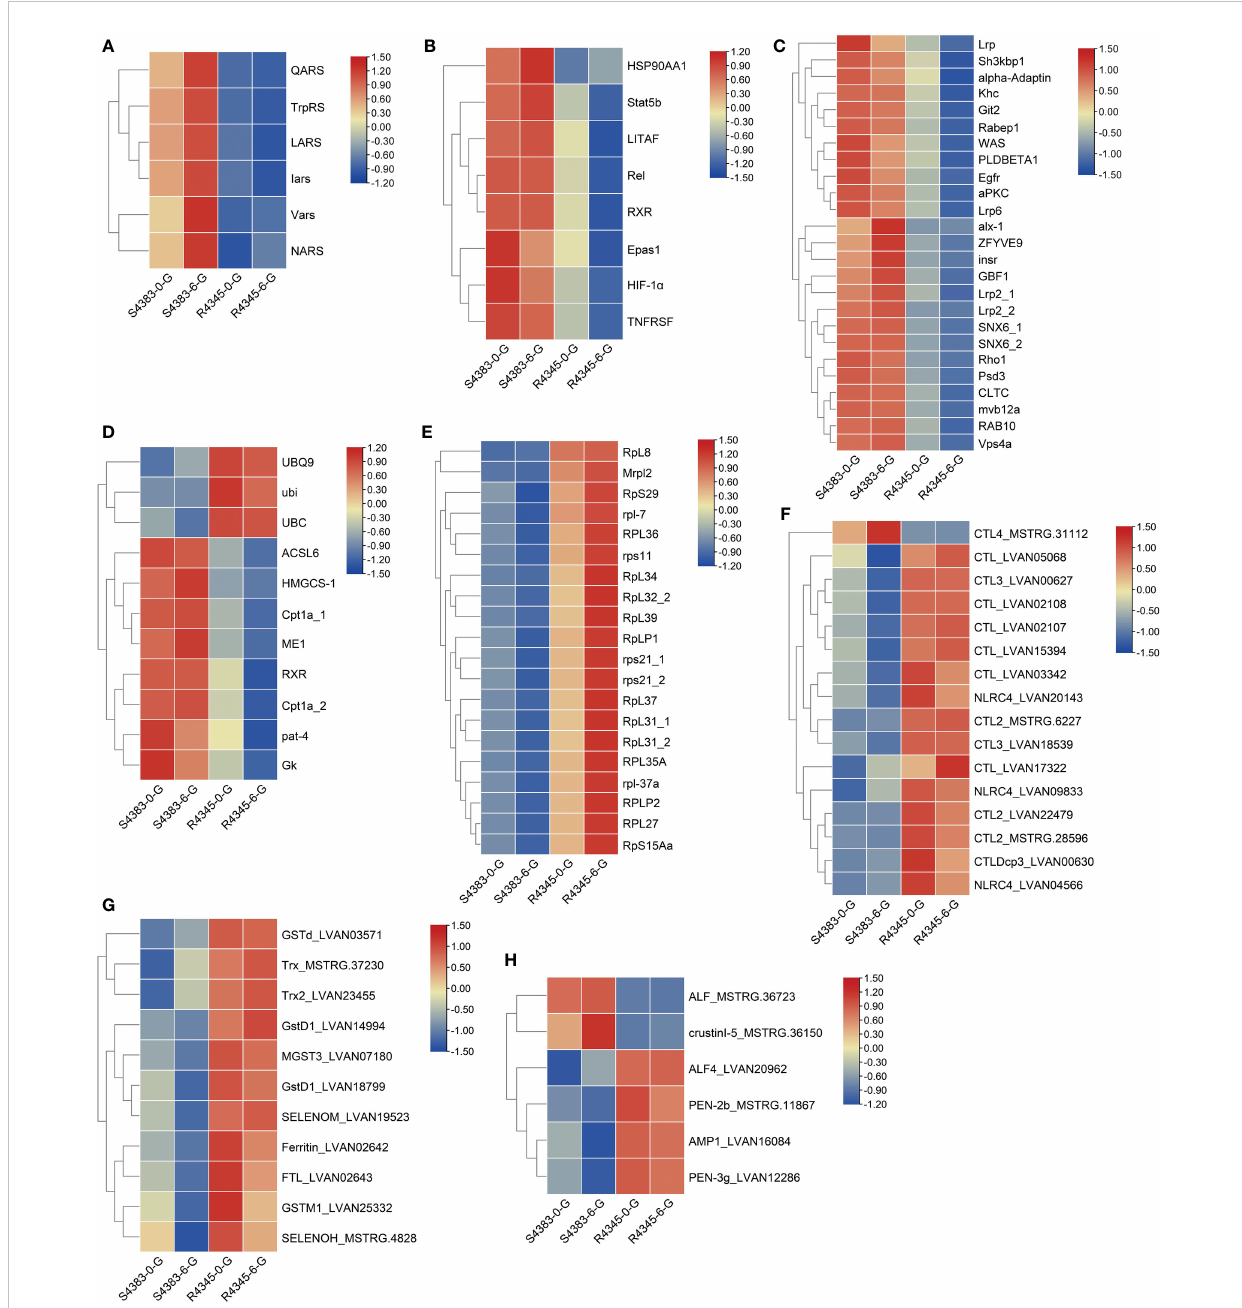
FIGURE 6 Heatmap of the expression patterns of key DEGs shared between the two comparison groups S4383-0-G vs R4345-0-G and S4383-6-G vs R4345- 6-G. (A) DEGs involved in aminoacyl-tRNA ligase activity (GO:0004812). (B) DEGs involved in Th17 cell differentiation (ko04659) and in fl ammation. (C) DEGs involved in endocytosis (ko04144). (D) DEGs involved in PPAR signaling pathway (ko03320). (E) DEGs involved in ribosome (ko03010). (F) DEGs identi fi ed as pattern recognition receptors (PRRs). (G) DEGs identi fi ed as antioxidants. (H) DEGs identi fi ed as antimicrobial peptides